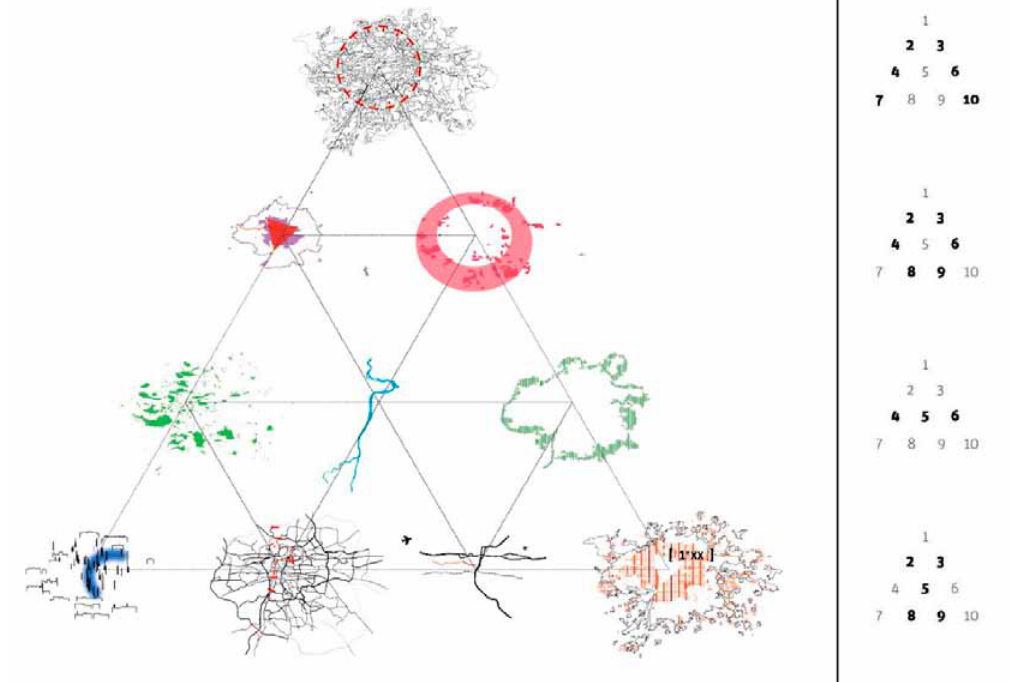
fig. 3. System of tetractys – ten elementary theses to the city of Prague and their mutual interconnections Source: IPr Praha,